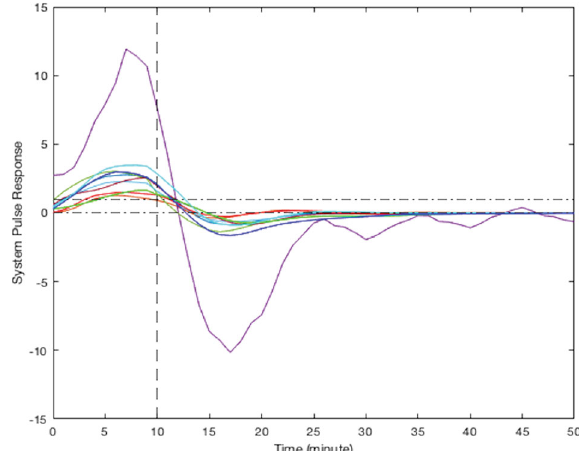
Fig. 6 Pulse response for participants in cluster 2, a delayed increase followed by a sharp decrease in smoking odds. The